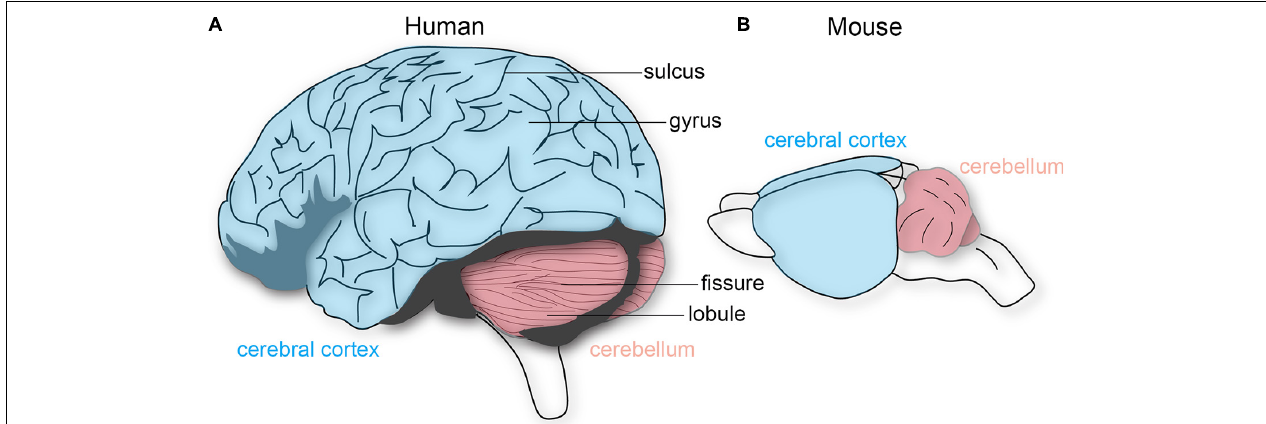
FIGURE 1 | Schematic depiction of the human and mouse brain. (A) The human cerebral cortex (blue) and cerebellum (pink) both have characteristic folding patterns. The cerebral cortex contains gyri (peaks) that are interrupted by sulci (valleys). An equivalent architecture is observed in the cerebellum, which is comprised of lobules and fissures. (B) The mouse cerebellum is folded whereas the cerebral cortex is not. The brains are not drawn to